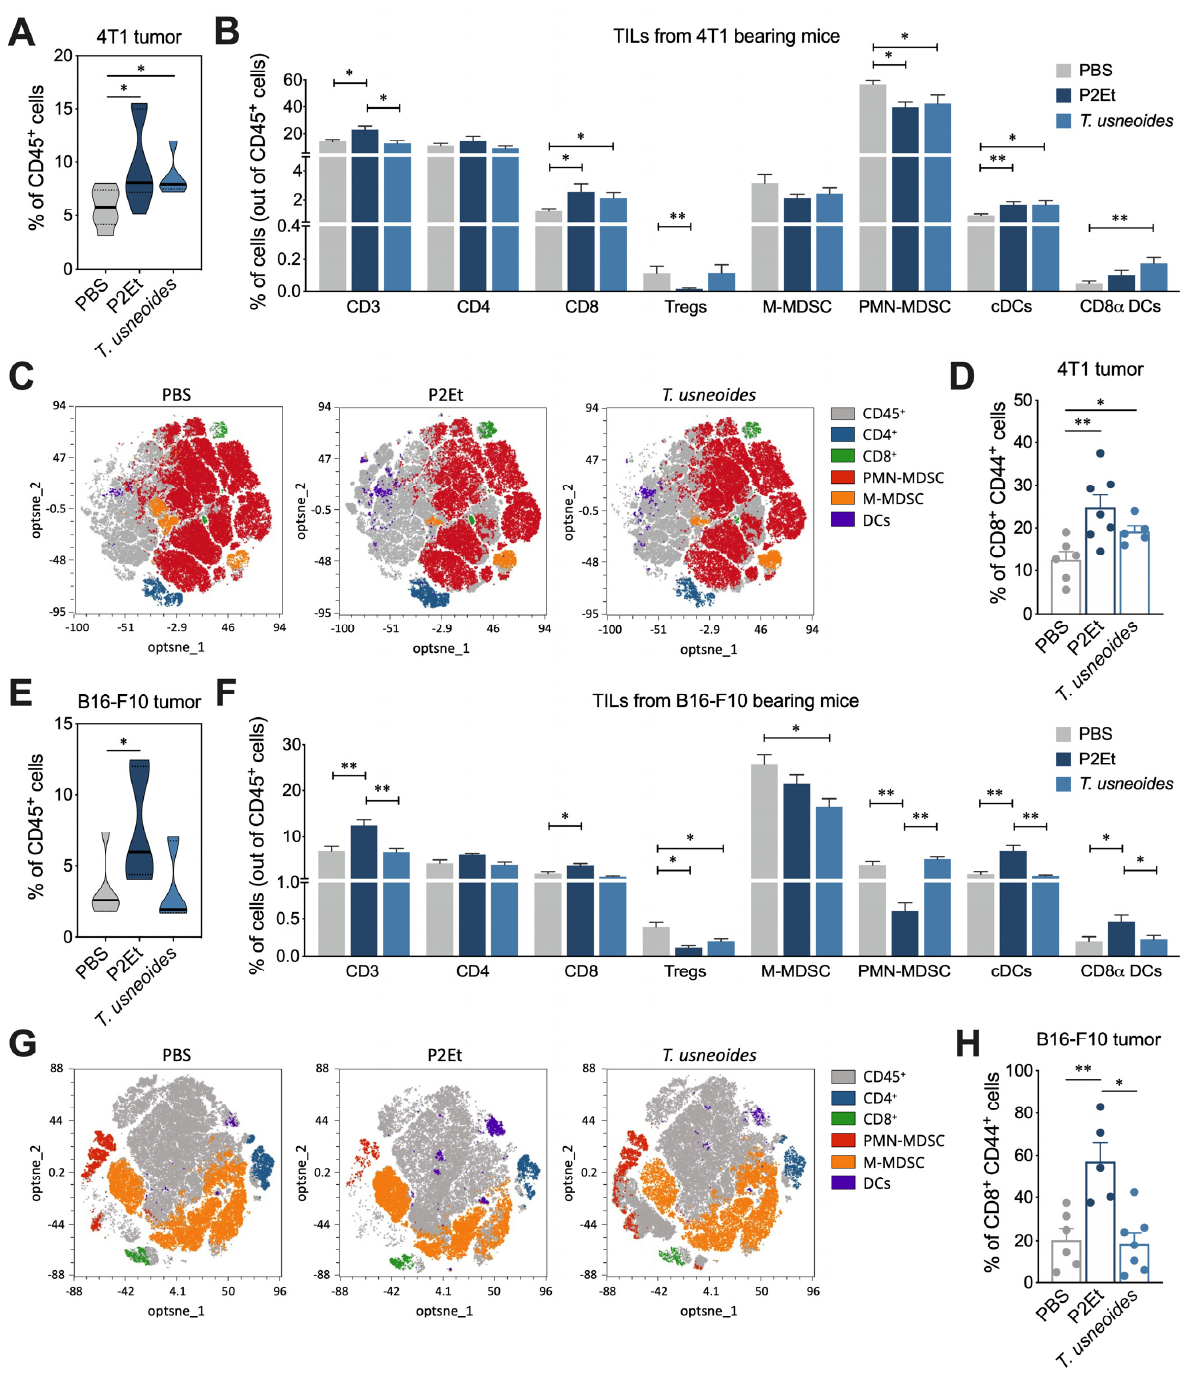
Figure 4. T. usneoides extract modulates the tumor microenvironment in 4T1 breast cancer tumor. ( A ). Frequency of 4T1 intratumor CD45 + cells in mice treated with P2Et, T. usneoides , or PBS (control). ( B ). Overview of the immune cell composition in the 4T1 TME shown in the percentage of cells